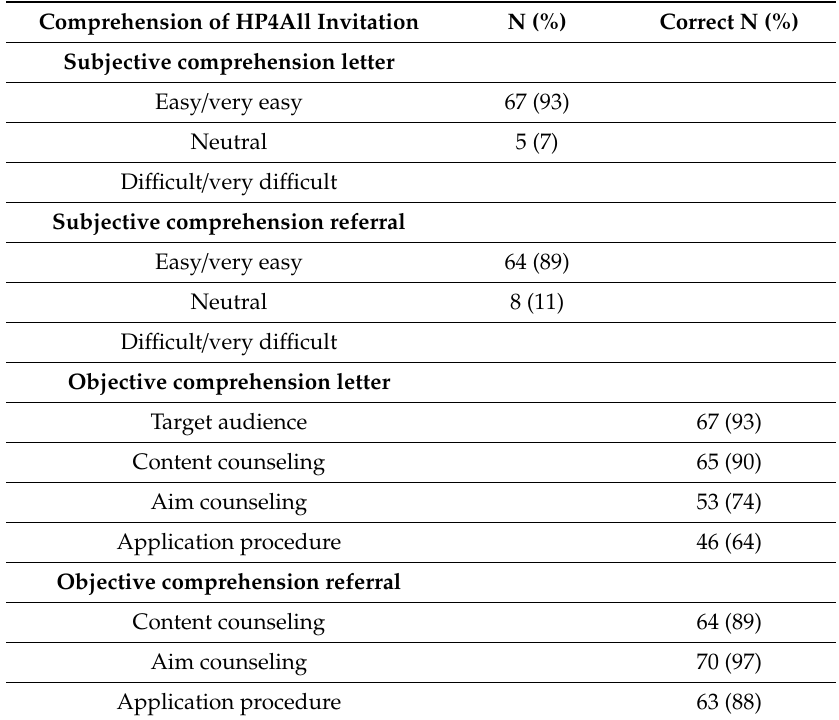
Table 4. Comprehension of HP4All invitation (n =